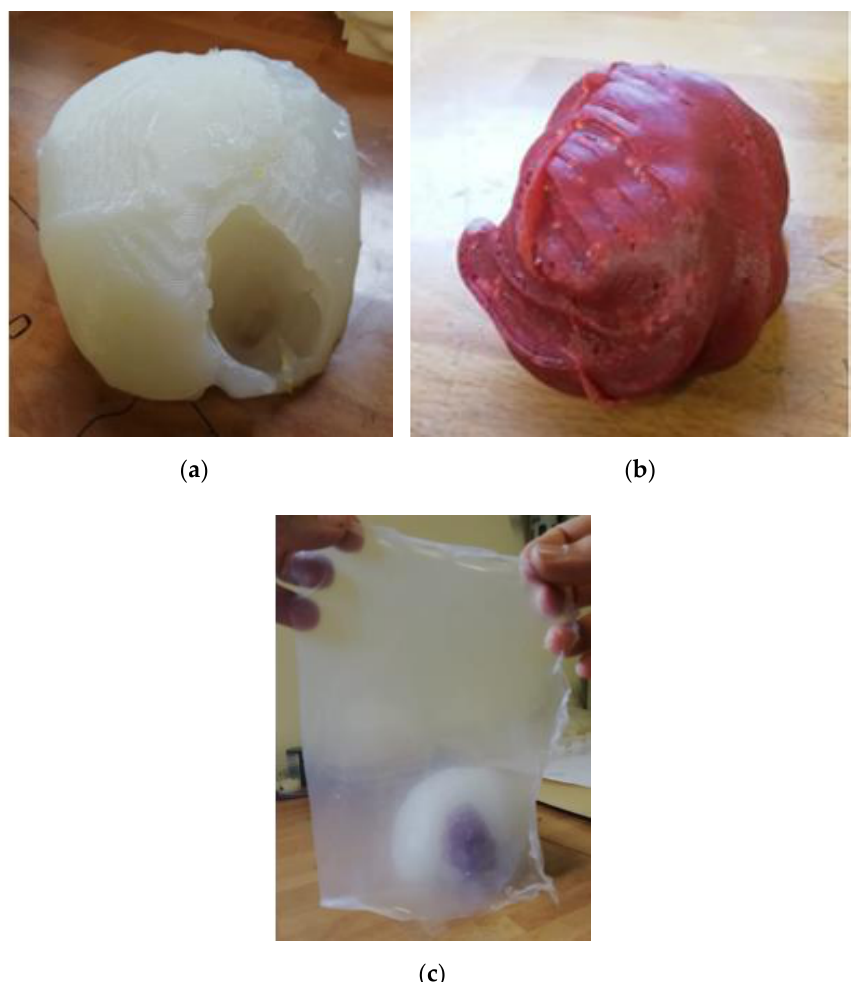
Figure 7. Casting of the different silicones in different proportions for the brain ( a ), tumor ( b ), and dura mater ( c ) models.